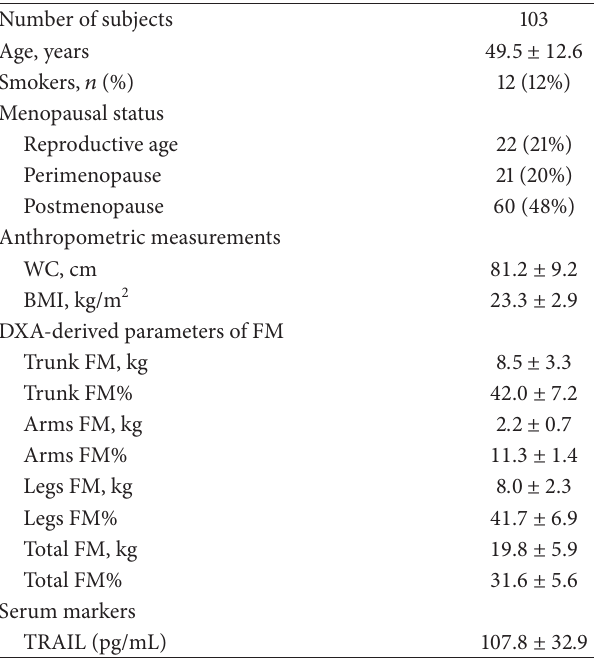
Table 1: Sample characteristics.